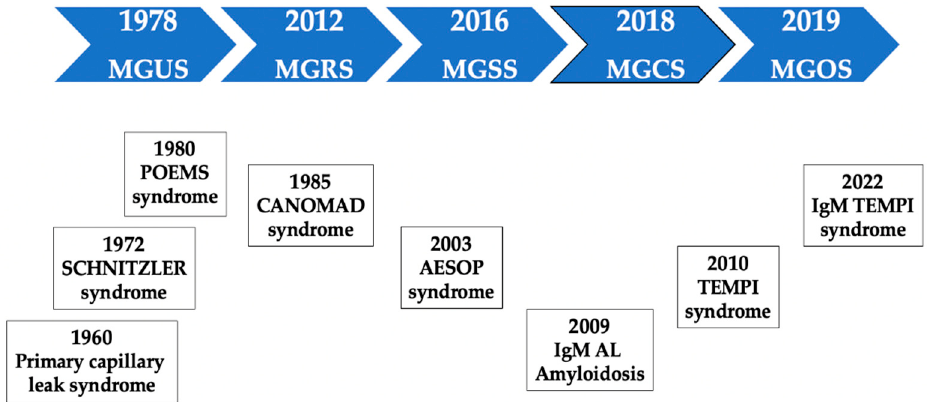
Figure 1. Schematic timeline of selected MGCS disorders. Abbreviations: AESOP; adenopathy and extensive skin patch overlying a plasmacytoma, CANOMAD; chronic ataxic neuropathy, ophthal- moplegia, monoclonal IgM protein, cold agglutinins, anti-disialosyl antibodies MGs; monoclonal gammopathies, MGCS; MG of clinical significance, MGOS; MG of ocular significance, MGNS; MG of neurological significance † , MGRS; MG of renal significance, MGSS; MG of skin significance, MGUS; MG of undetermined significance, POEMS; polyradiculoneuropathy (P), organomegaly (O), endocrinopathy(E), monoclonal gammopathy (M), and skin changes (S) syndrome, TEMPI; Telangiectasias, elevated erythropoietin level and Erythrocytosis, Monoclonal gammopathy, Perinephric fluid collections, and Intrapulmonary shunting. † MGNS is not a term formally coined in a specific moment of time. Before the term MGCS was coined, the name “paraproteinemic neuropathy” was commonly used to describe the association (not always causal) between MG and neuropathy. Since 2018, MGNS has been an increasingly used term, and some old entities, such as CANOMAD syndrome, have been recognized as belonging to this group.